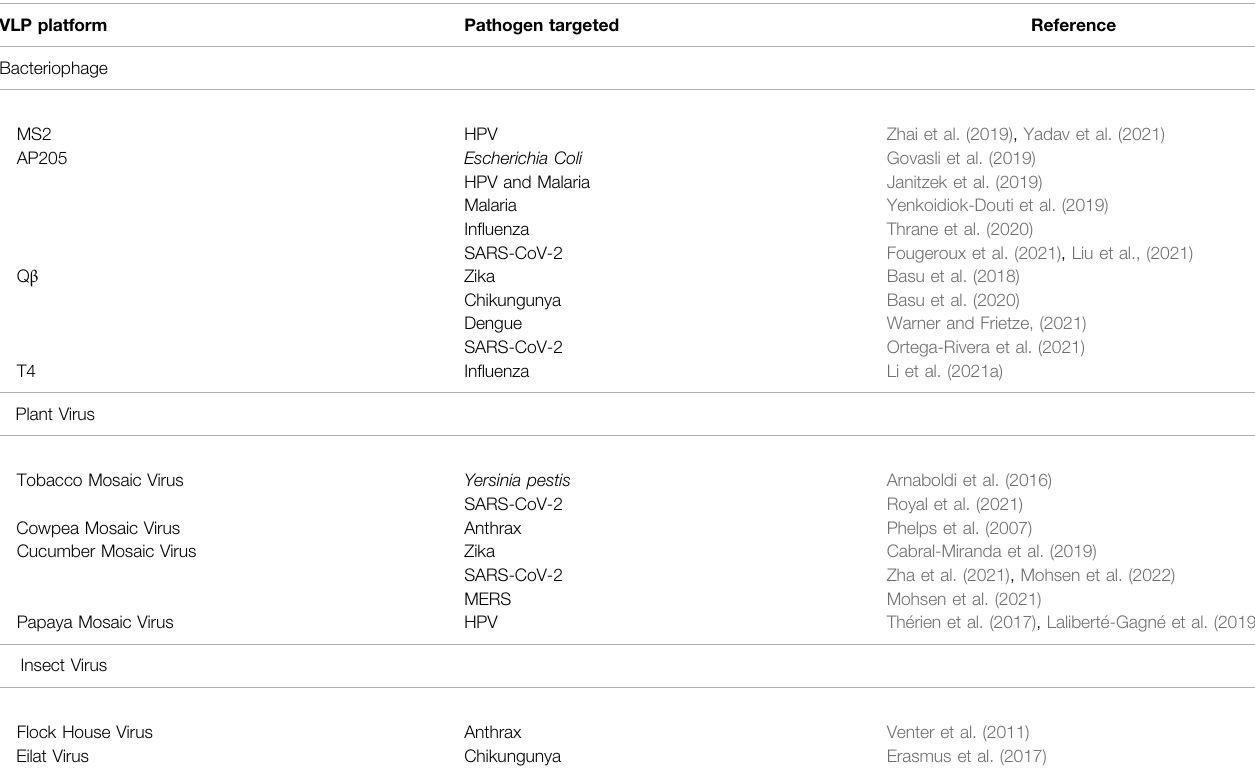
TABLE 3 | VLPs used as vaccine